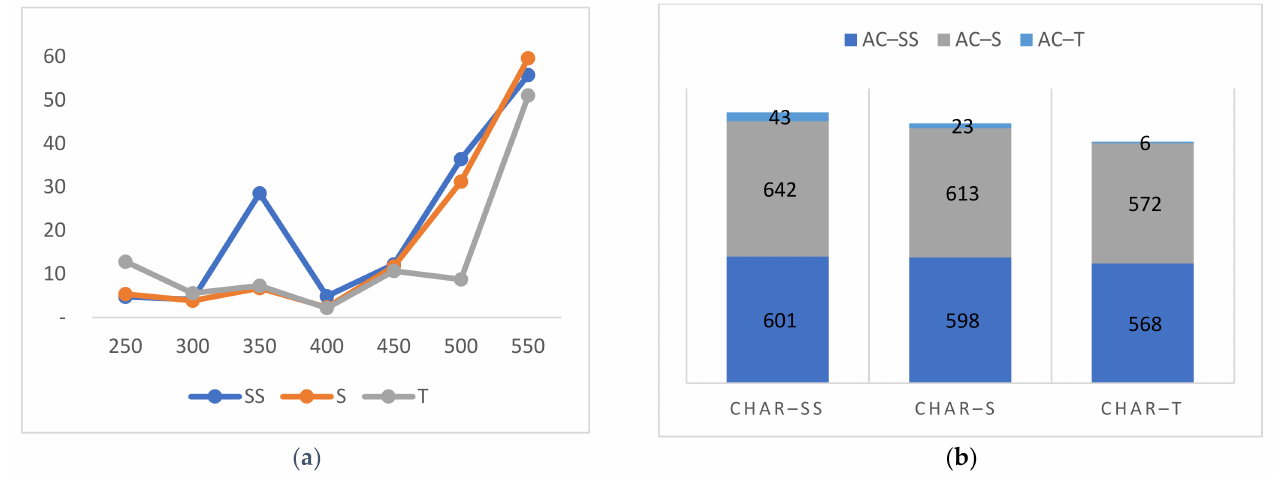
Figure 2. BET surface area in m 2 /g. ( a ) pyrochar, ( b ) activated